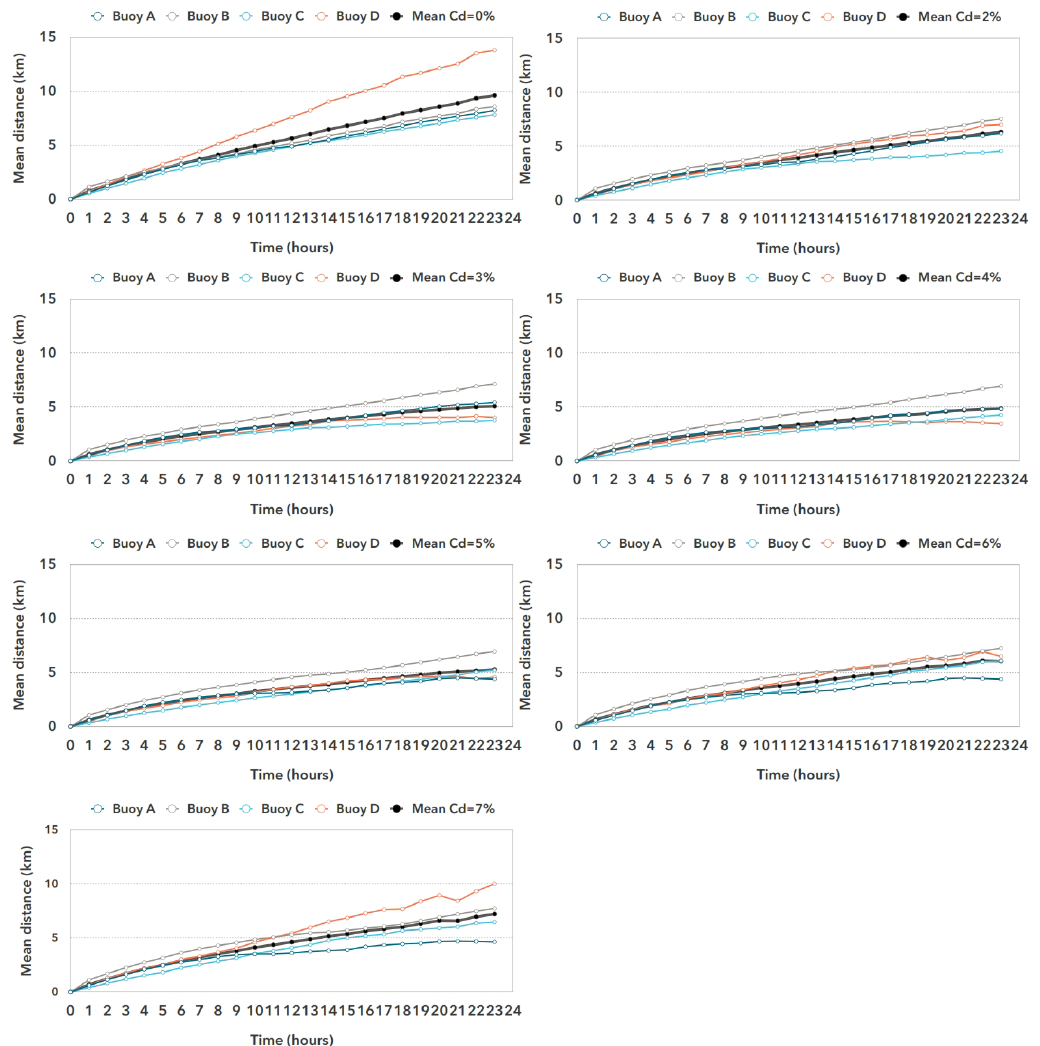
Figure 5. Mean separation distance between modelled and observed trajectories for each wind drag coefficient. The dark line is the mean curve used for the trapezoidal